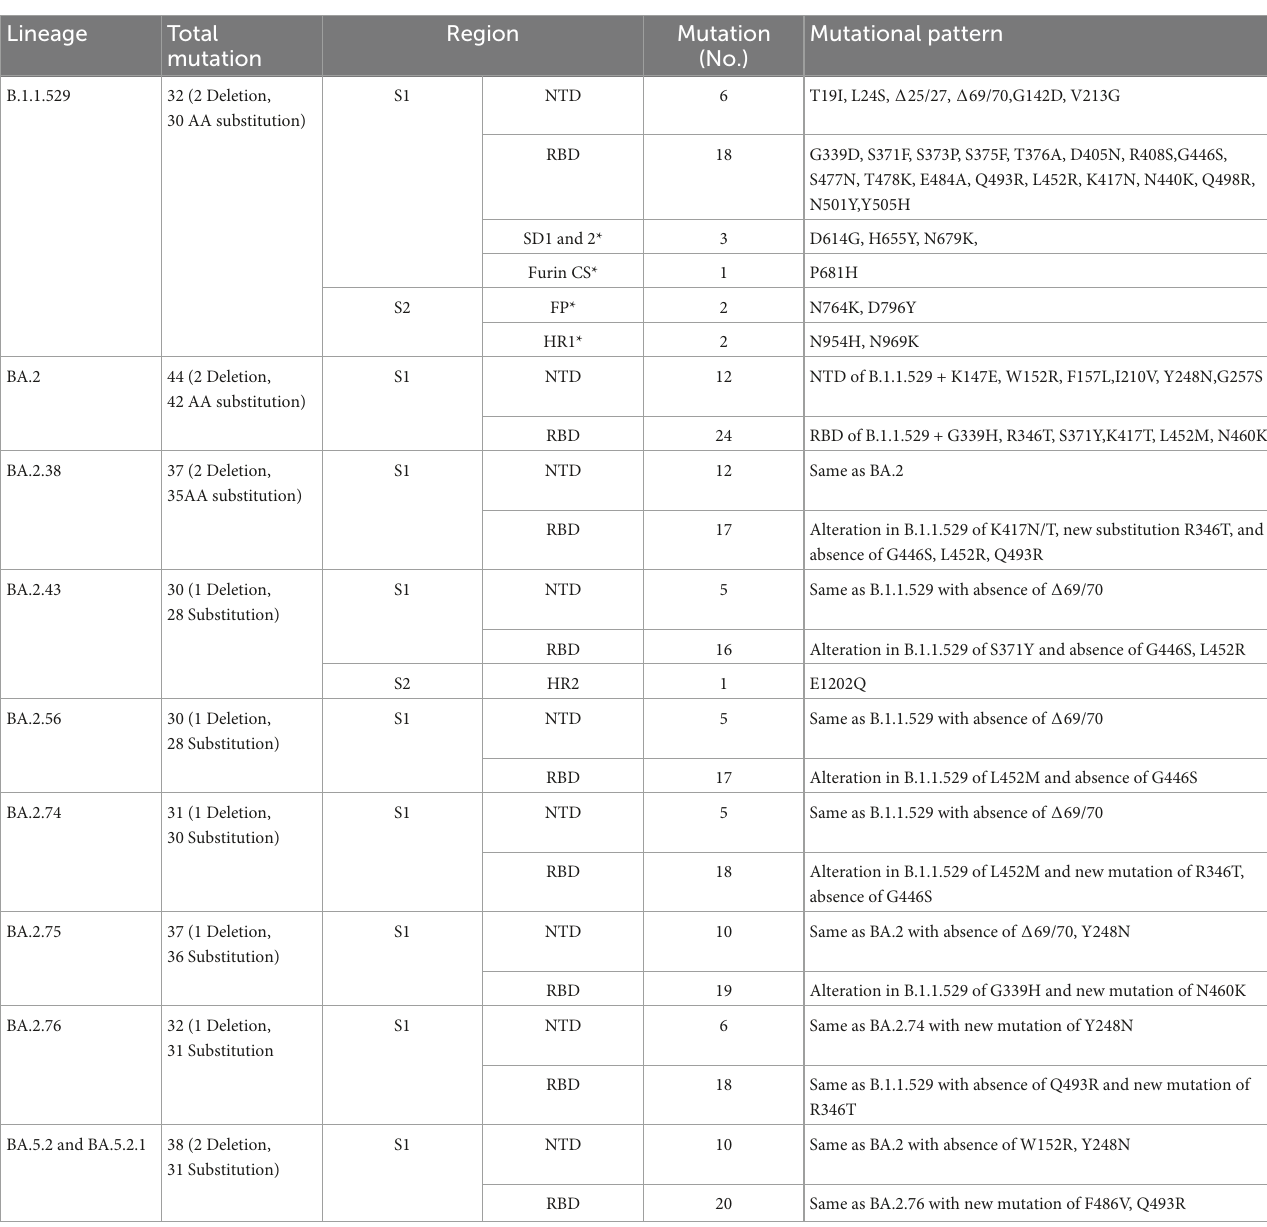
TABLE 1 Omicron different lineages mutational pattern in spike protein. Lineage Total